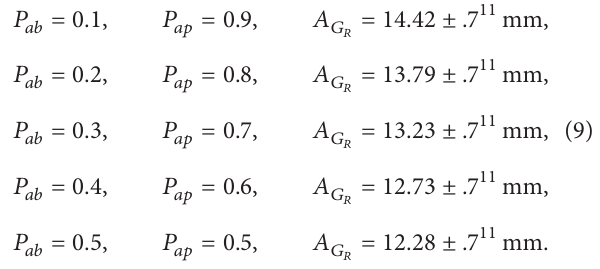
Figure 2: The mean ± SD of fractal dimension for different probabilities of 𝑎 𝑏 , where 𝑎 𝑝 has the probability 𝑃 𝑎𝑝 = 1 − 𝑃 𝑎𝑏 .